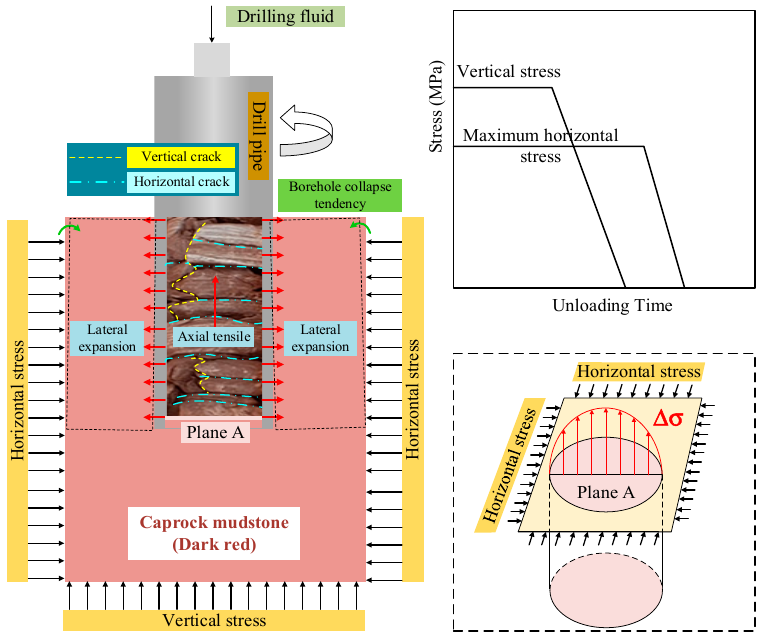
Figure 14. The stress release diagram in the process of coring.